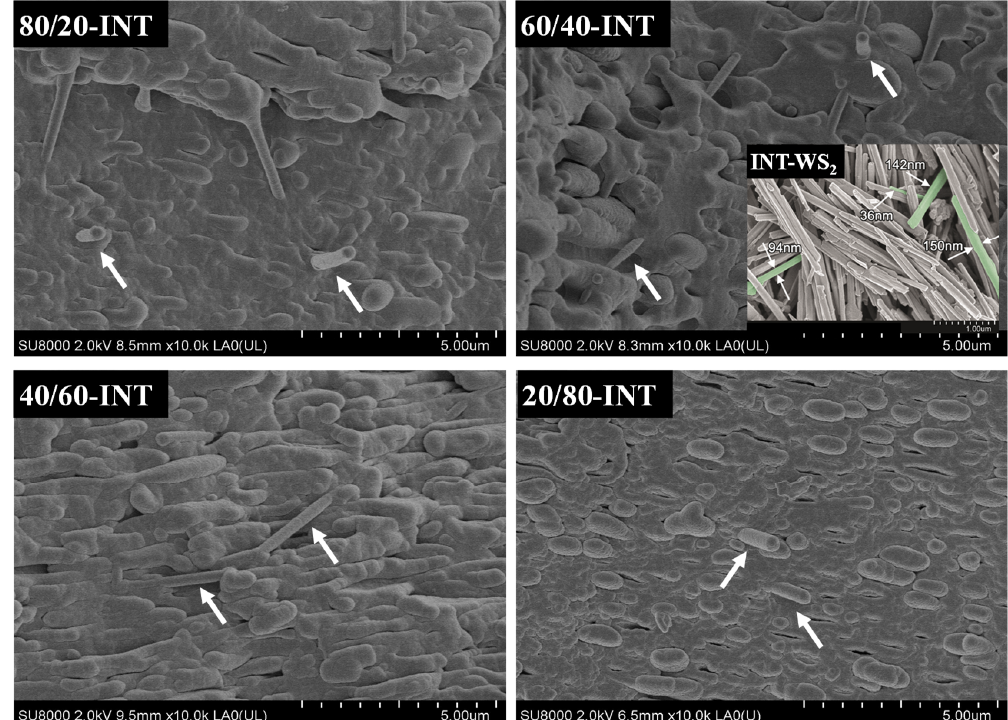
Figure 2. High-resolution SEM image for ternary PLLA/PVDF/INT-WS 2 hybrid nanocomposites; the inset shows the nano- tube dimensions (thicknesses) of as received INT-WS 2 .